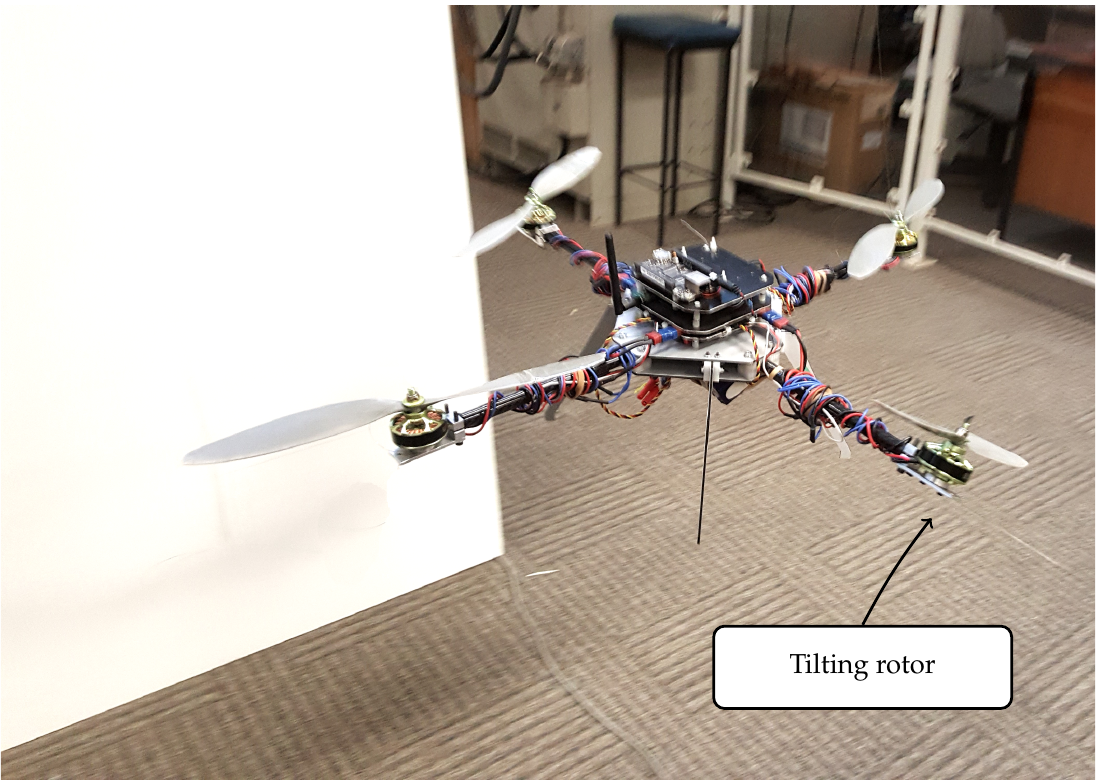
Figure 8. Single tilt-rotor multirotor helicopter in flight.